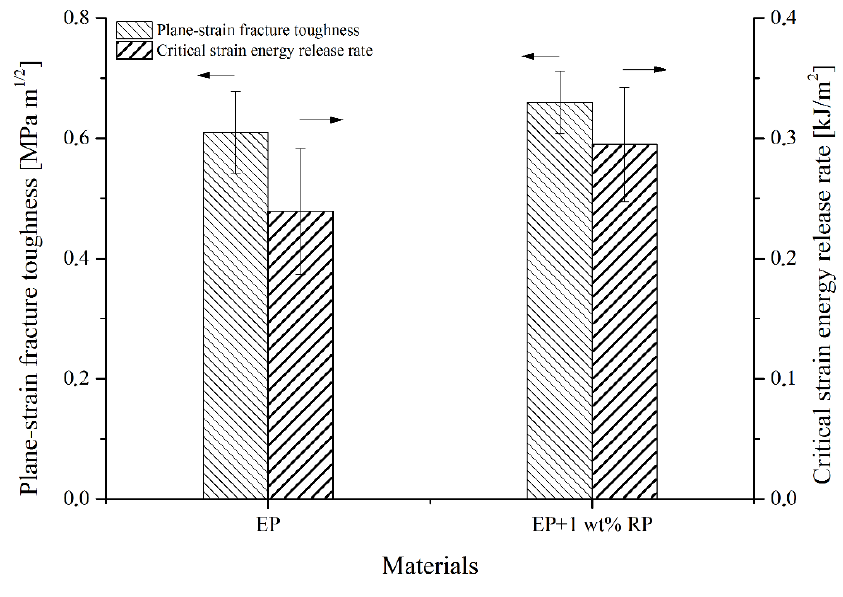
Figure 9. Results of CT tests of rubber-filled and pure epoxies.